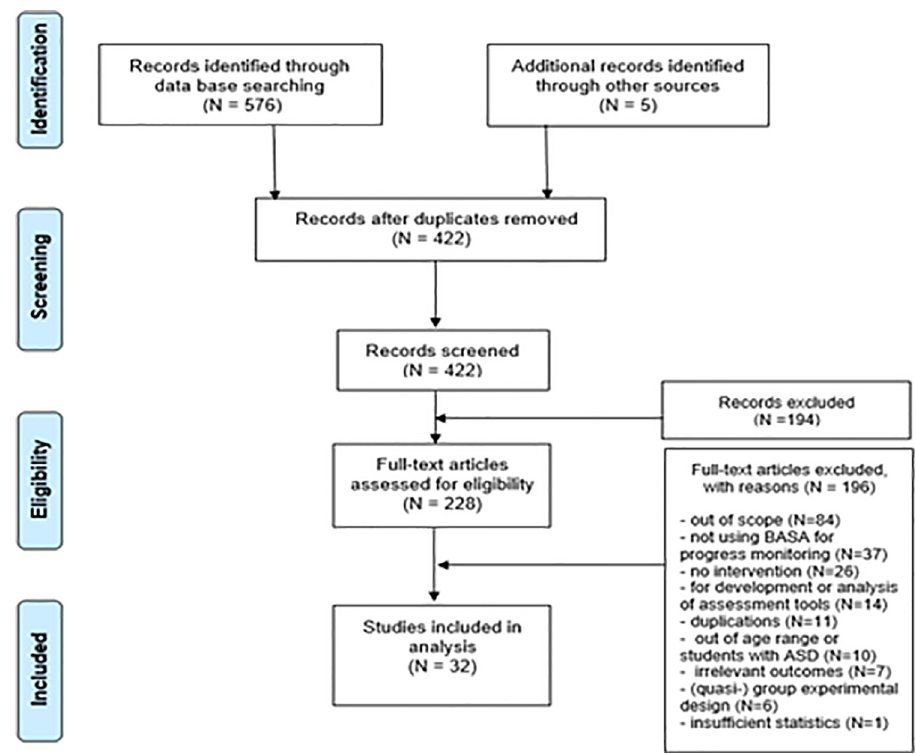
Fig 1. PRISMA flowchart for data